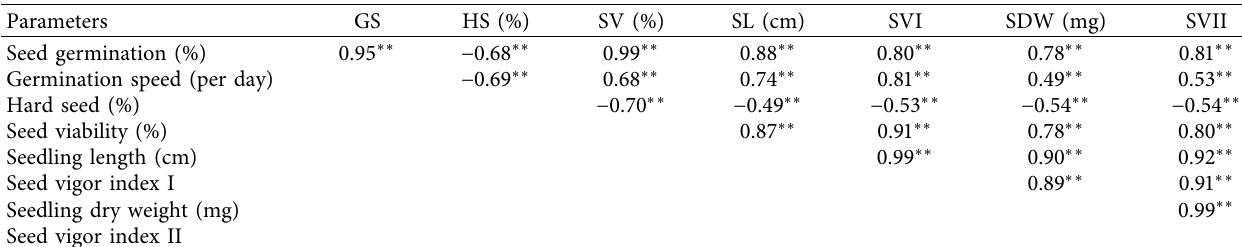
Table 7: Correlation coefcients for seed quality parameters as afected by genotype and seed priming treatments.